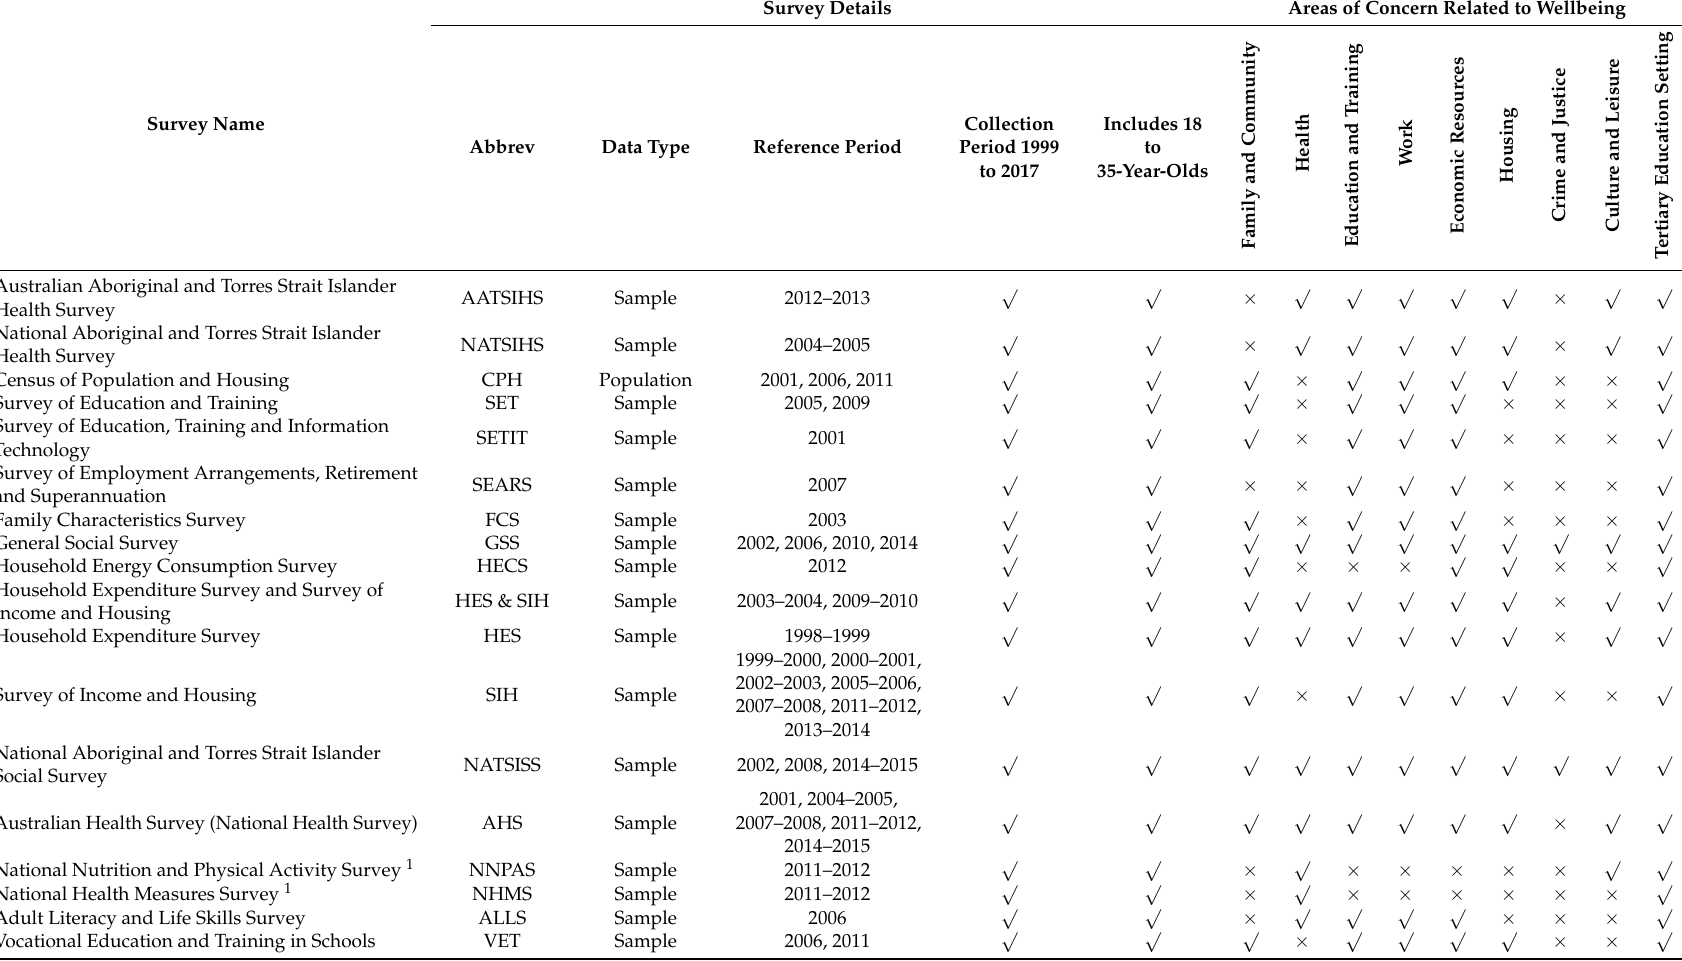
Table 2. Survey name and details of Australian Bureau of Statistics surveys collecting data on areas of concern impacting wellbeing of Australian young